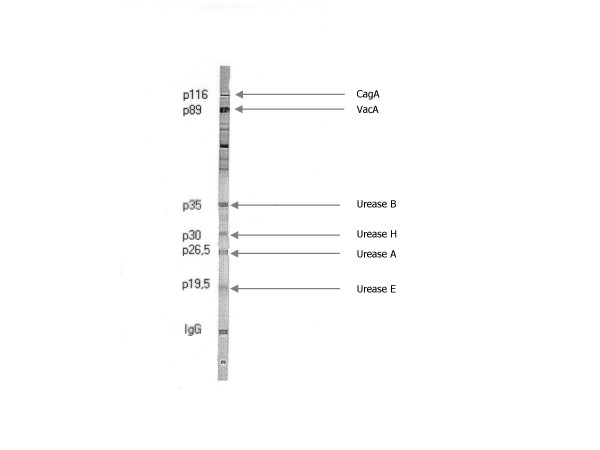
Western Blot for H. pylori infection.